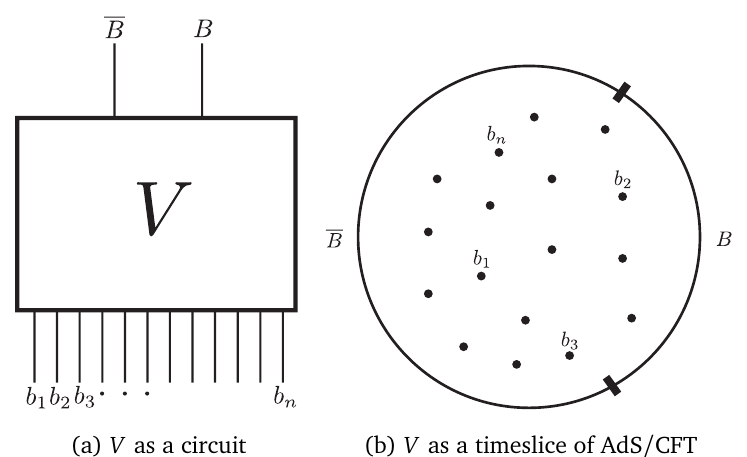
Figure 2: Two illustrations of the quantum codes used throughout this paper. (a) → H ⊗ H H A linear map V : ⊗ . (b) This linear map encompasses situations i b i B B in holography. Each input leg corresponds to a bulk point or subregion, while the output legs correspond to boundary subregions. The map V is